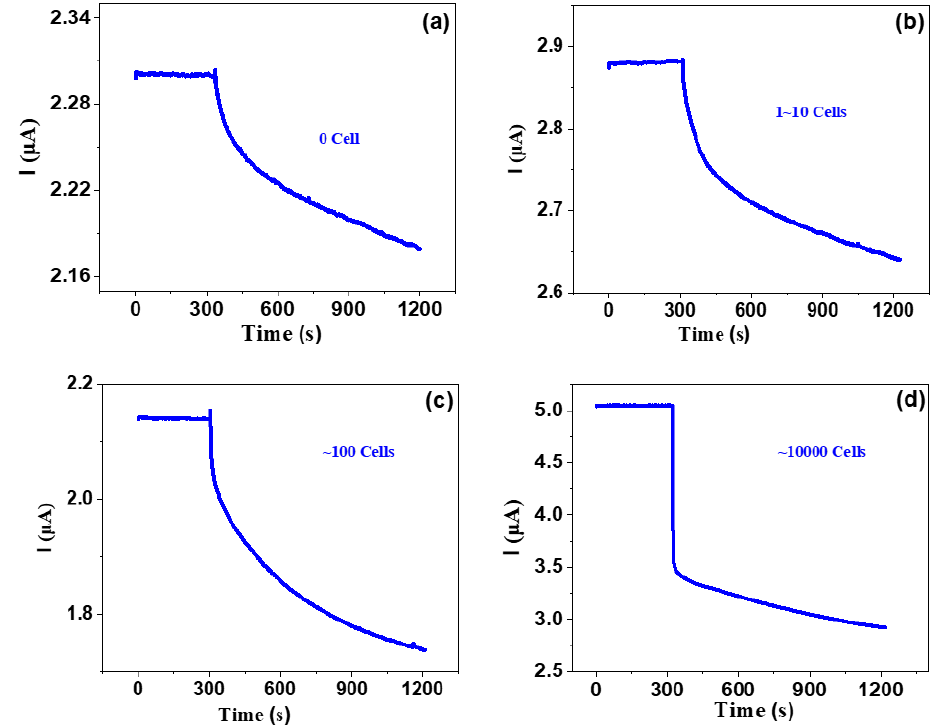
Figure 4. Response of various concentrations of ovarian cancer cells.